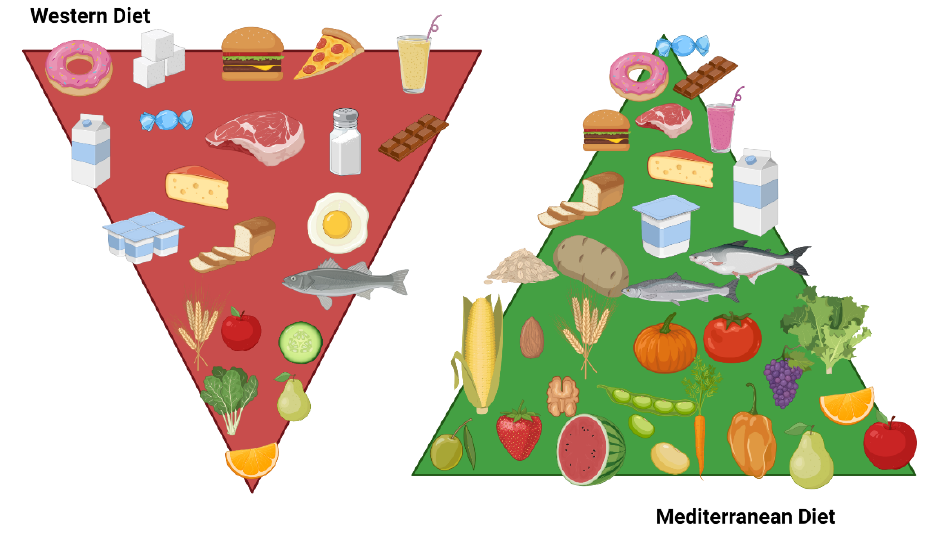
Figure 3. Mediterranean diet and Western diet.